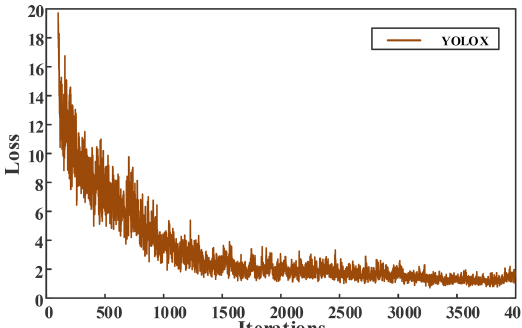
Figure 9. Loss function value change curve of YOLOX.